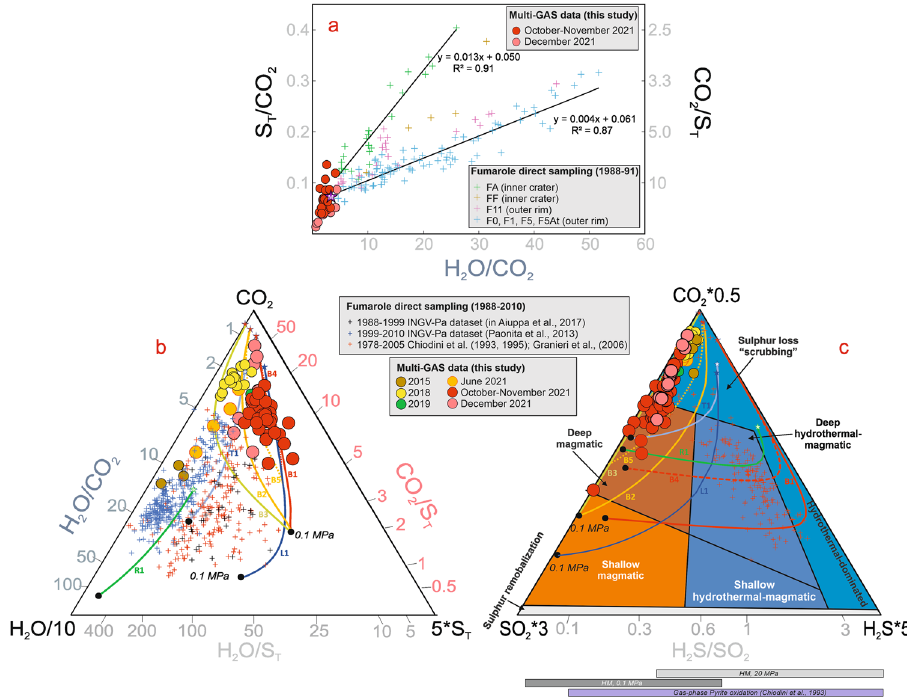
Fig. 4 Volcanic gas composition at La Fossa crater. a Scatter plot comparing the October-December 2021 Multi-GAS results with directly sampled fumarole data taken in 1988 – 91, at the peak of the 1988 – 93 unrest 19 . The 1988 – 91 fumarole data identify two linear trends (for inner crater and crater rim fumaroles, respectively) that converge toward a magmatic pole (purple star labelled M) characterised by low H 2 O/CO 2 and S T /CO 2 ratios (the magmatic end-member of ref. 19 ). The October-December 2021 data (this study) match this magmatic signature; b H 2 O/10-CO 2 -5·S T triangular plot, comparing the composition of the La Fossa October-December 2021 fumarolic plume samples (Supplementary Table 2) with previous Multi-GAS (Supplementary Table 2) and direct sampling (see legend for data provenance) results. The fall 2021 data cluster in a relatively narrow area of unusually high S T , and low H 2 O, compositions. The curves show the model-predicted pressure-dependent evolution of the magmatic gas phase at equilibrium with silicate melts, obtained during the degassing model runs (see Supplementary Table 4; curve B6 not shown for clarity but see Supplementary Fig. 4). Stars identify equilibrium gas at initial pressure conditions. The B1-B5 model curves are for a basaltic magma with 1 – 2 wt.% initial CO 2 content and redox conditions from NNO-1 to NNO + 1 (see Supplementary Table 4). Models L1 and T1 are for latitic and K-trachytic magmas, and R1 for a rhyolitic magma composition (see Supplementary Table 4); c 0.5CO 2 -3SO 2 -5·H 2 S triangular plot for the La Fossa fumaroles (symbols and curves as in ( b )). The compositional fi elds of typical volcanic gas types/processes are from ref. 27 ). The fall 2021 La Fossa gases vary compositionally along a relatively narrow area stretching between the fi elds of deep magmatic gases and hydrothermal gases (having suffered S loss via hydrothermal scrubbing processes). The bars at the bottom of the diagram illustrate the calculated equilibrium gas H 2 S/SO 2 ratios for hydrothermal gases buffered at the Hematite-Magnetite (HM) buffer at 0.1 to 20 MPa pressure (ref. 48 ), and for steam-driven pyrite oxidation 19